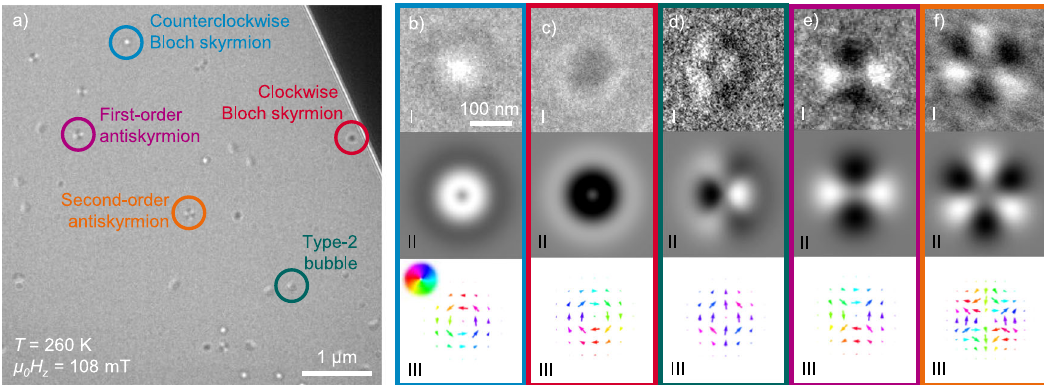
Fig. 1 Variety of spin objects. a Underfocused LTEM image of [Fe/Ir/Gd] 2 /[Fe/Gd] 76 /[Fe/Ir/Gd] 2 taken in an applied oop magnetic fi eld µ 0 H z of 108 mT at the temperature T of 260 K. Five different coexisting spin objects are observed. The images b – f , (I) show the measured zoomed-in spin objects and b – f , (II) display the simulated LTEM contrast caused by the theoretical spin textures shown in b – f , (III). In b – f , III the arrows and their color depict the directions of the ip components, with their sizes displaying the strengths. b Bloch skyrmion with counter- and c with clockwise rotation, d type-2 bubble, e fi rst-order antiskyrmion, and f second-order